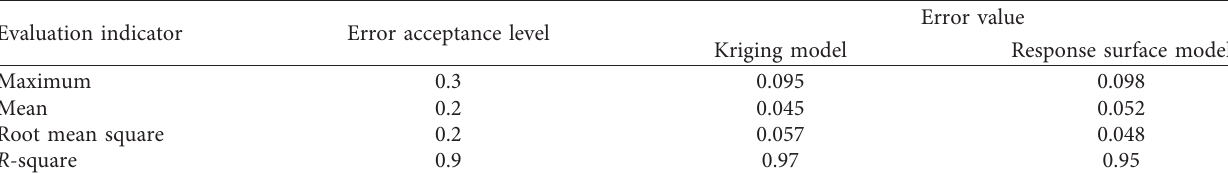
Table 6: Evaluation indicators of the Kriging model.